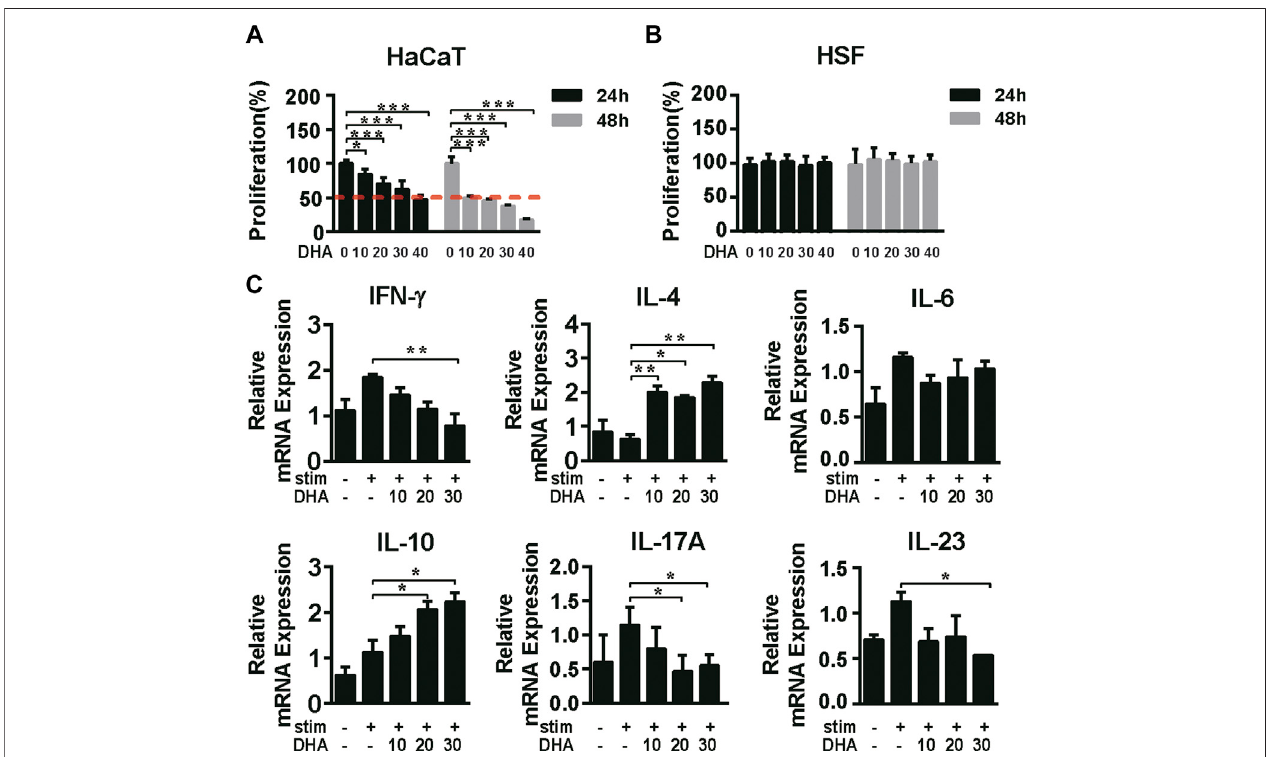
FIGURE1| TheeffectofDHAontheproliferationofHaCaTcellsand theexpressionofcytokines. (A,B) ThecellviabilityofHaCaTcellsandHSFcellswasdetected byMTT assaybeing treatedwith differentconcentrationsofDHAfor 24and 48 h(* p (cid:2) 0.0318,*** p < 0.001). (C) Aftertreatment onHaCaT cellswith 0,10,20, 30 μ g/ml DHA for 24 h with the stimulation ofIFN- γ (10 ng/ml) and TNF- α (10 ng/ml),the mRNA expression ofin fl ammation-related cytokines IFN- γ , IL-4, IL-6, IL-10, IL-17A, and IL-23wasdetectedbyRT-PCR(IFN- γ ,** p (cid:2) 0.0094;IL-4,* p (cid:2) 0.0292,** p < 0.05;IL-6, NS. Notsigni fi cant;IL-10,* p < 0.05;IL-17A,* p < 0.05;IL-23,* p (cid:2) 0.0335). The signi fi cant difference was compared relatively to the DHA untreated group. Statistical analysis was carried out using One-way ANOVA analysis of variance followed by Dunnett ’ s test ( n (cid:2) 5 – 7).